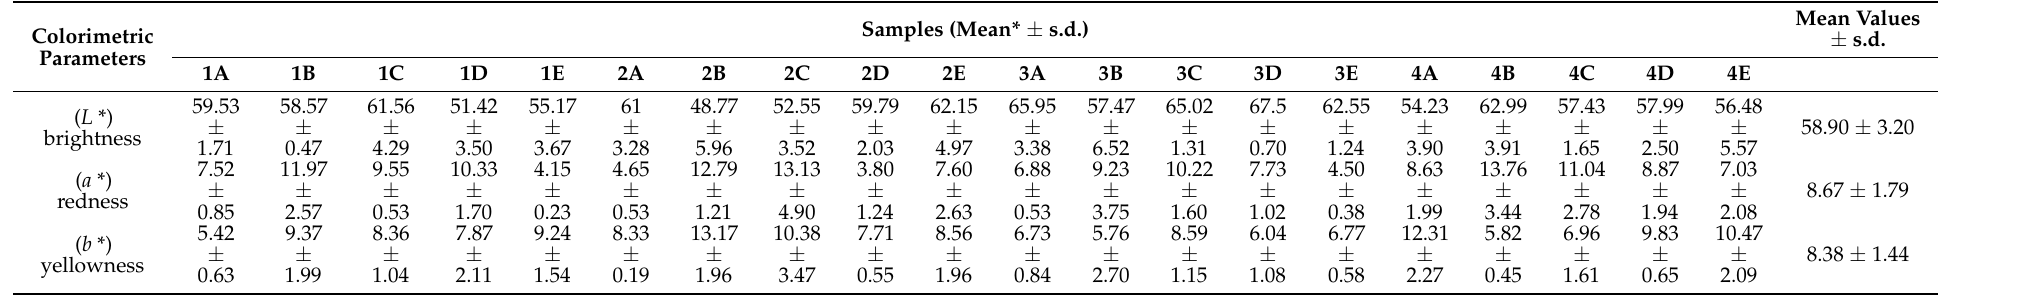
Table 5. Colorimetric parameters (mean ± s. d.) of yellowfin tuna samples included in the study. Colorimetric